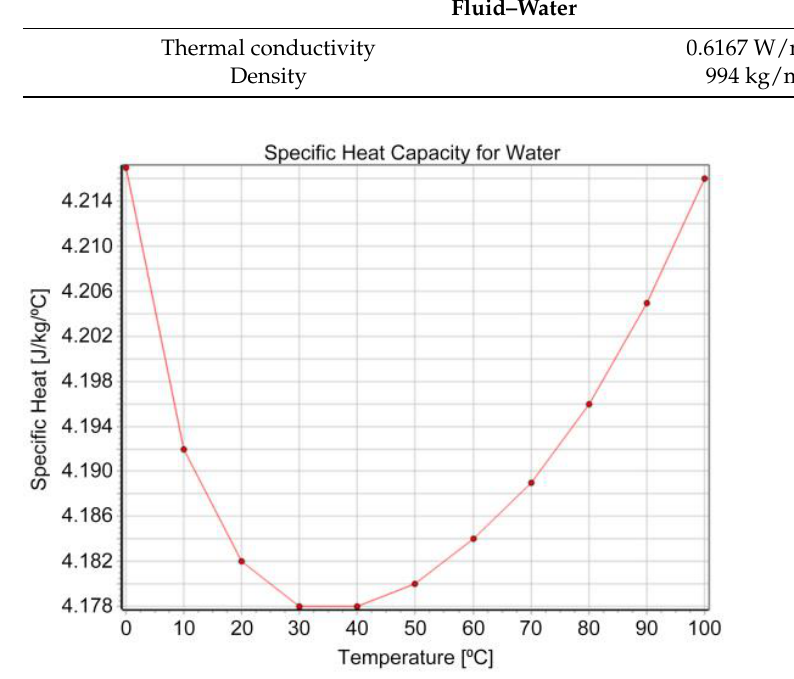
Figure 11. Specific heat capacity of water.